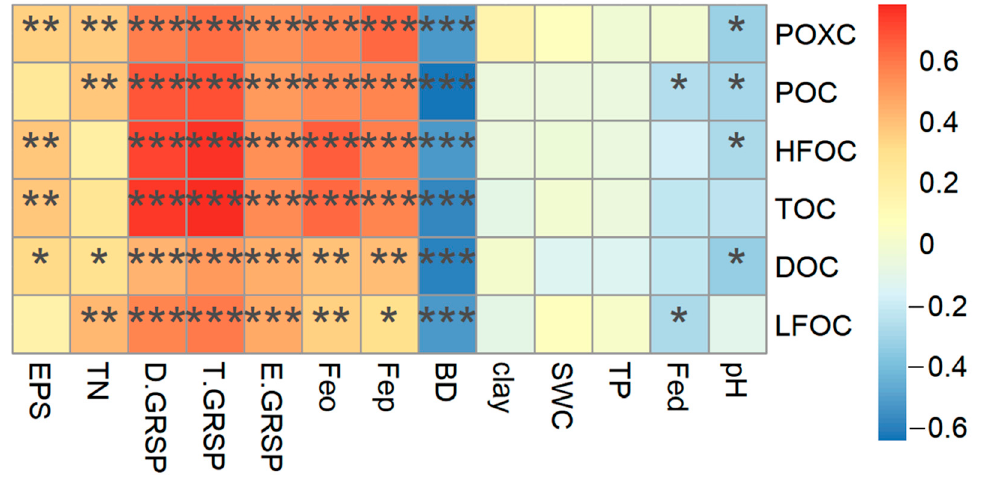
Figure 6. Pearson correlations of the soil carbon indices and soil properties for different vegetation types . *, **, and *** indicate significant correlation at 0.05, 0.01, and 0.001 level, respectively.